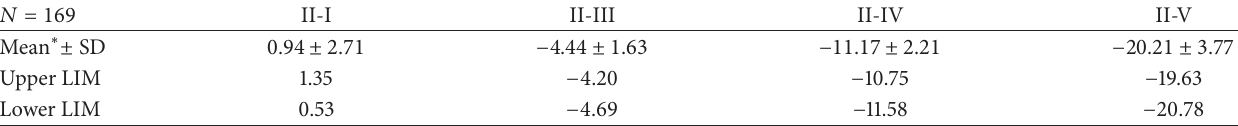
Table 1: Mean values of metatarsal protrusion related to II ray (in millimeters). Whole